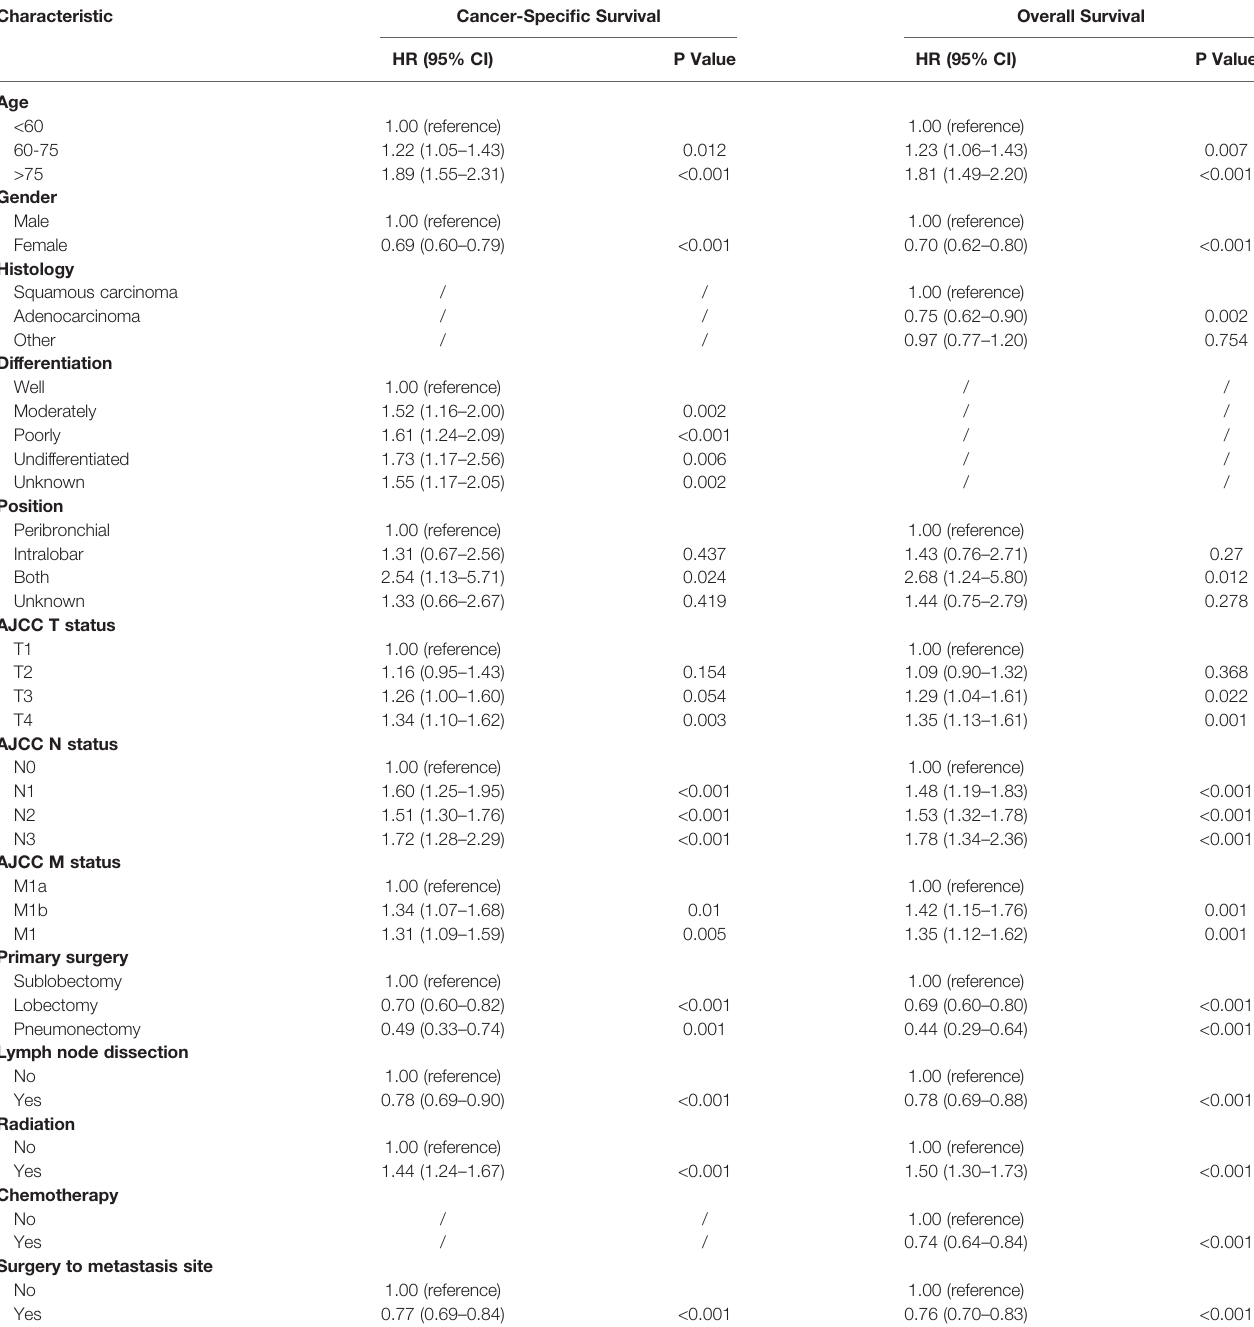
TABLE 2 | Multivariable analysis for lung cancer – speci fi c survival in patients with NSCLC with